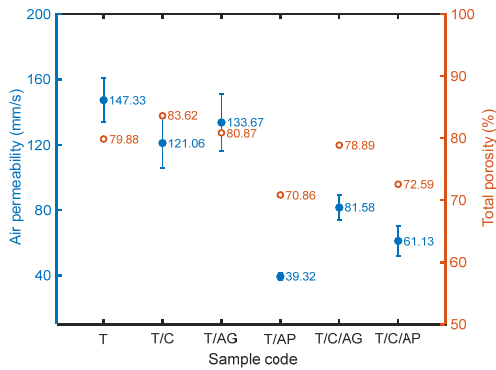
Figure 7. Air permeability and total porosity of the electro-sprayed materials.